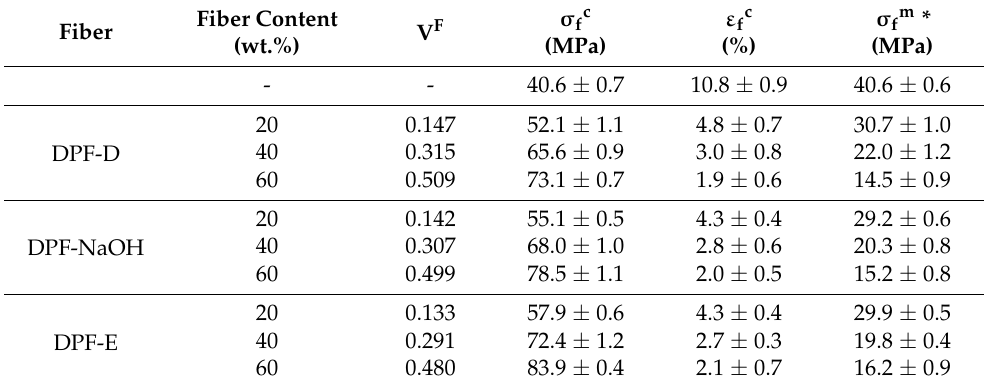
Table 2. Flexural properties of date palm fiber-based composites at 20, 40, and 60 wt.% fiber content. Fiber Fiber